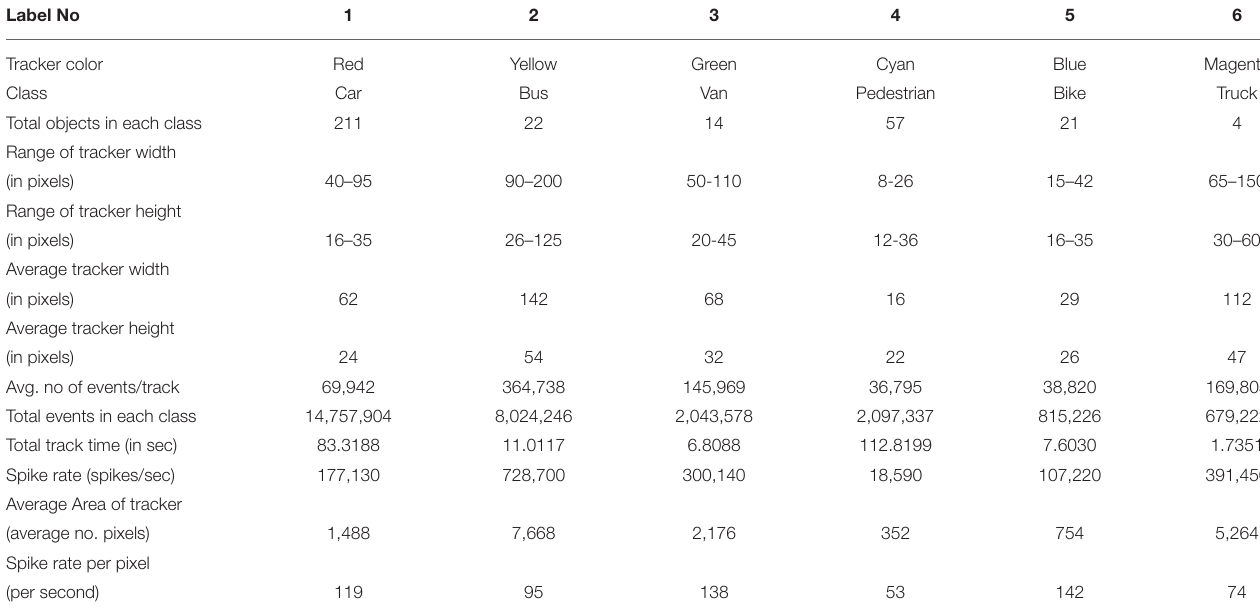
TABLE 2 | Details of each class of object present in the traffic data